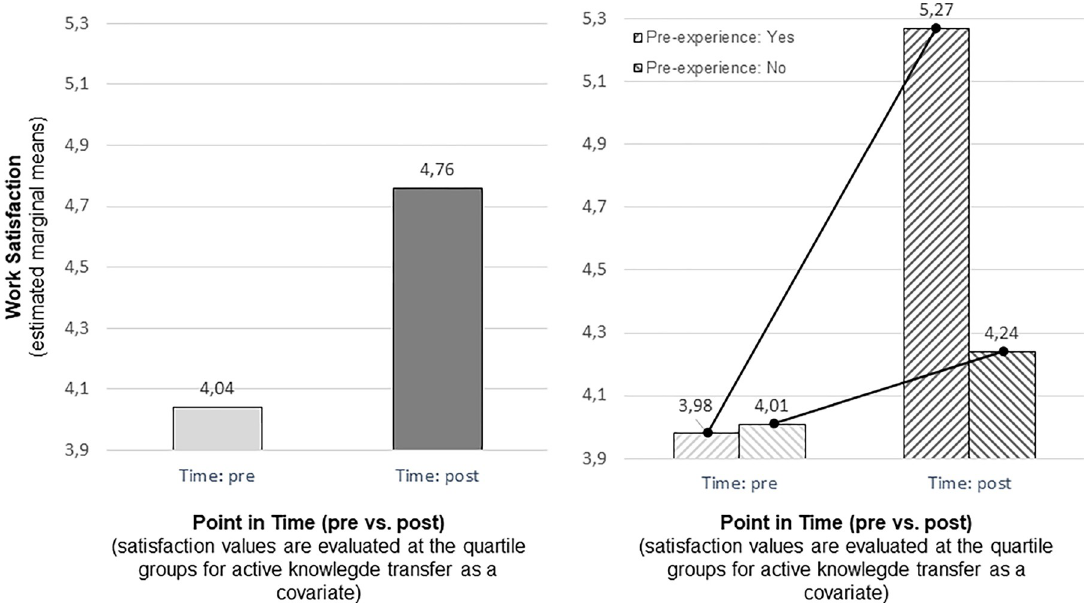
Fig 4. Impact of point in time (left) and interaction of time and experience (right) on